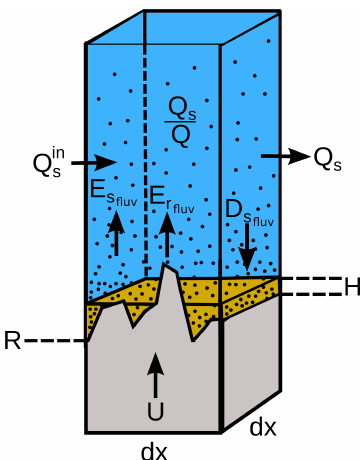
Figure 1. Sketch of fluvial SPACE component. Model setup and variable definitions for the SPACE bedrock–alluvial river erosion model. Entrainment and deposition of sediment, as well as erosion of bedrock, can occur simultaneously. This approach allows chan- nels to dynamically transition among bedrock, bedrock–alluvial and fully alluviated states. At a given stream power, the relative rates of sediment entrainment E s and bedrock erosion E r are set by fluv fluv the ratio of sediment thickness H to the bedrock roughness height H ∗ (Fig. 2). Modified from Shobe et al.